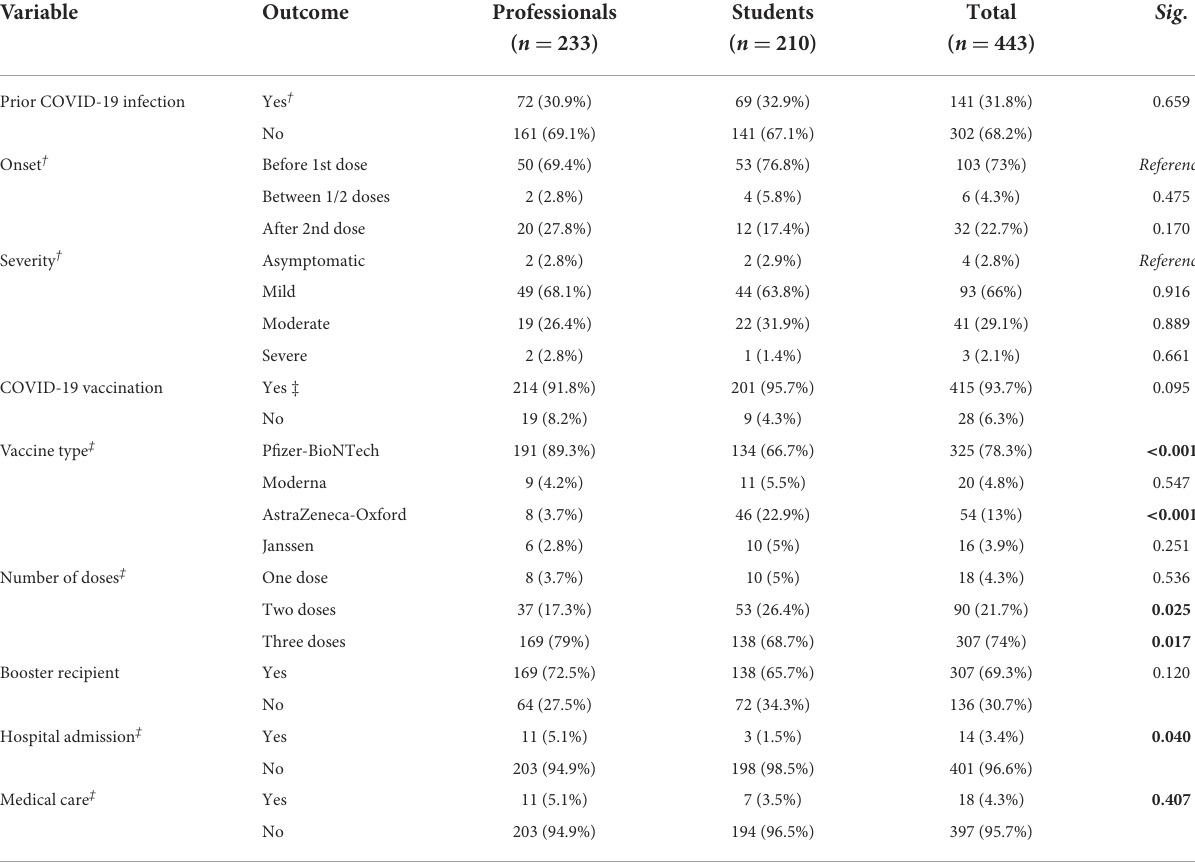
TABLE 2 Anamnestic characteristics of polish healthcare professionals and students responding to COVID-19 VBH survey, December 2021–January 2022 ( n = 443).